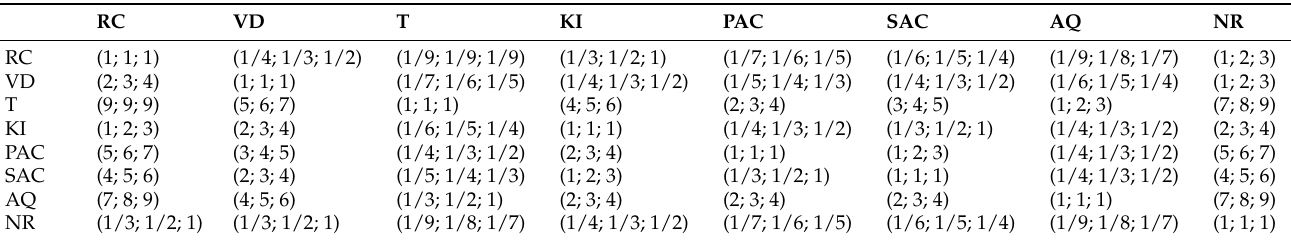
Table 5. Fuzzy pairwise comparison matrix.